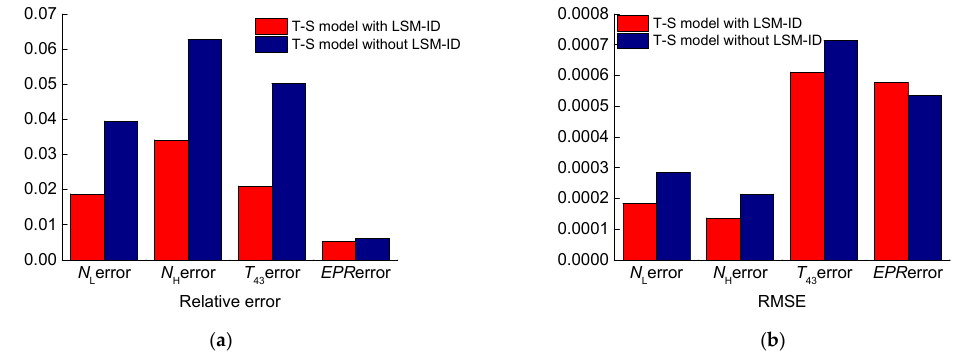
Figure 13. Relative error and RMSE compared with the nonlinear model under 7 km and 0.44 Mach. ( a ) Relative errors. ( b ) RMSEs.